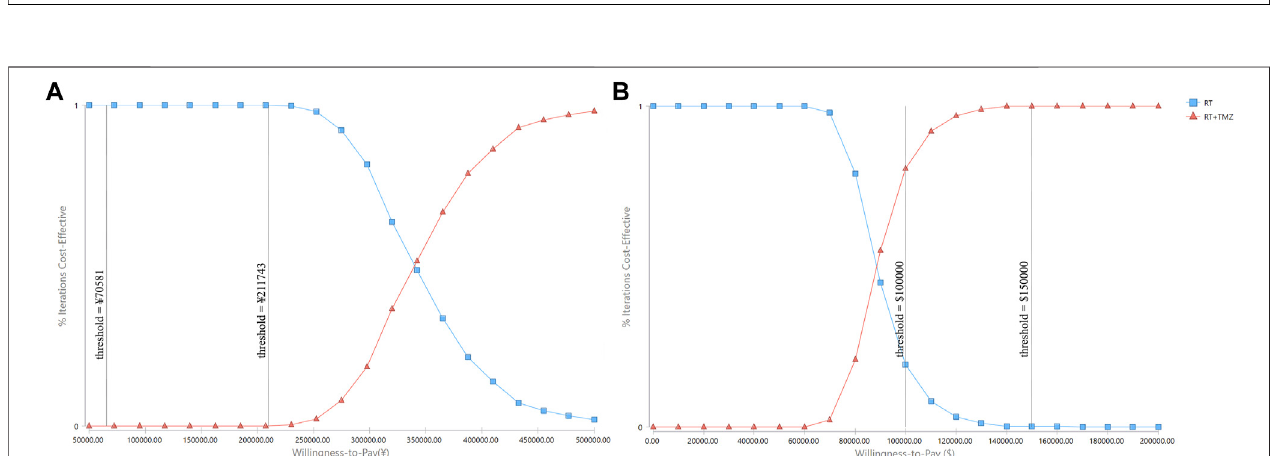
FIGURE 4 | Cost-effectiveness acceptability curves. RT: radiotherapy; TMZ: temozolomide.